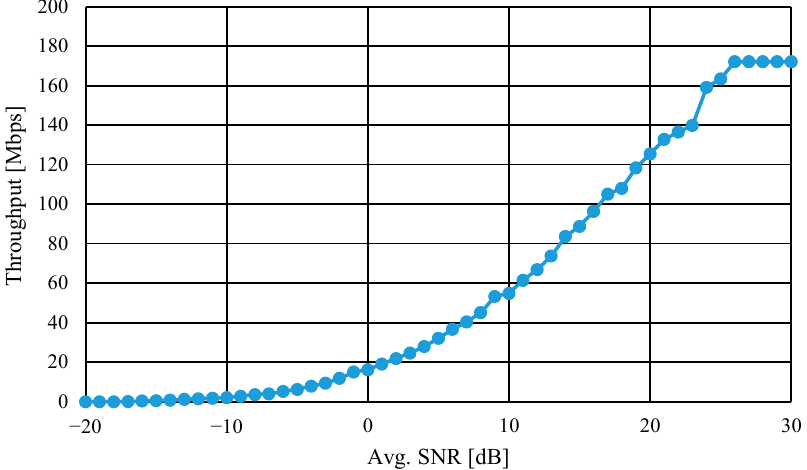
Figure 10. 𝑇 (cid:2918)_(cid:2897)(cid:2887)(cid:2903) (𝑆𝑁𝑅) performance versus uplink SNR. Figure 10. T h_MCS ( SNR ) performance versus uplink SNR.